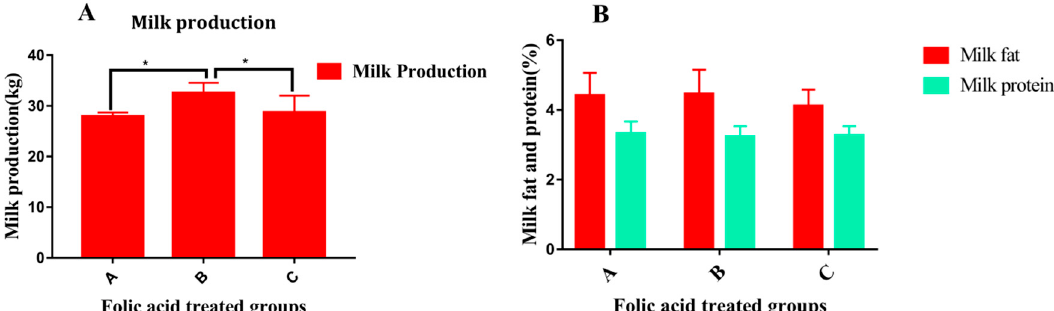
Figure 3. The e ff ect of folic acid quantity on milk production variables in periparturient dairy cows [58]. ( A ) Comparison of the average milk production status over three months in group B (120 mg / 500 kg body weight / cow), group A (240 mg / 500 kg body weight / cow), and group C (control). ( B ) Comparison of average milk fat and protein percentage in three folic acid-treated dairy cattle groups (A, B, and C). The * denotes that the di ff erence is significant and the p -value <